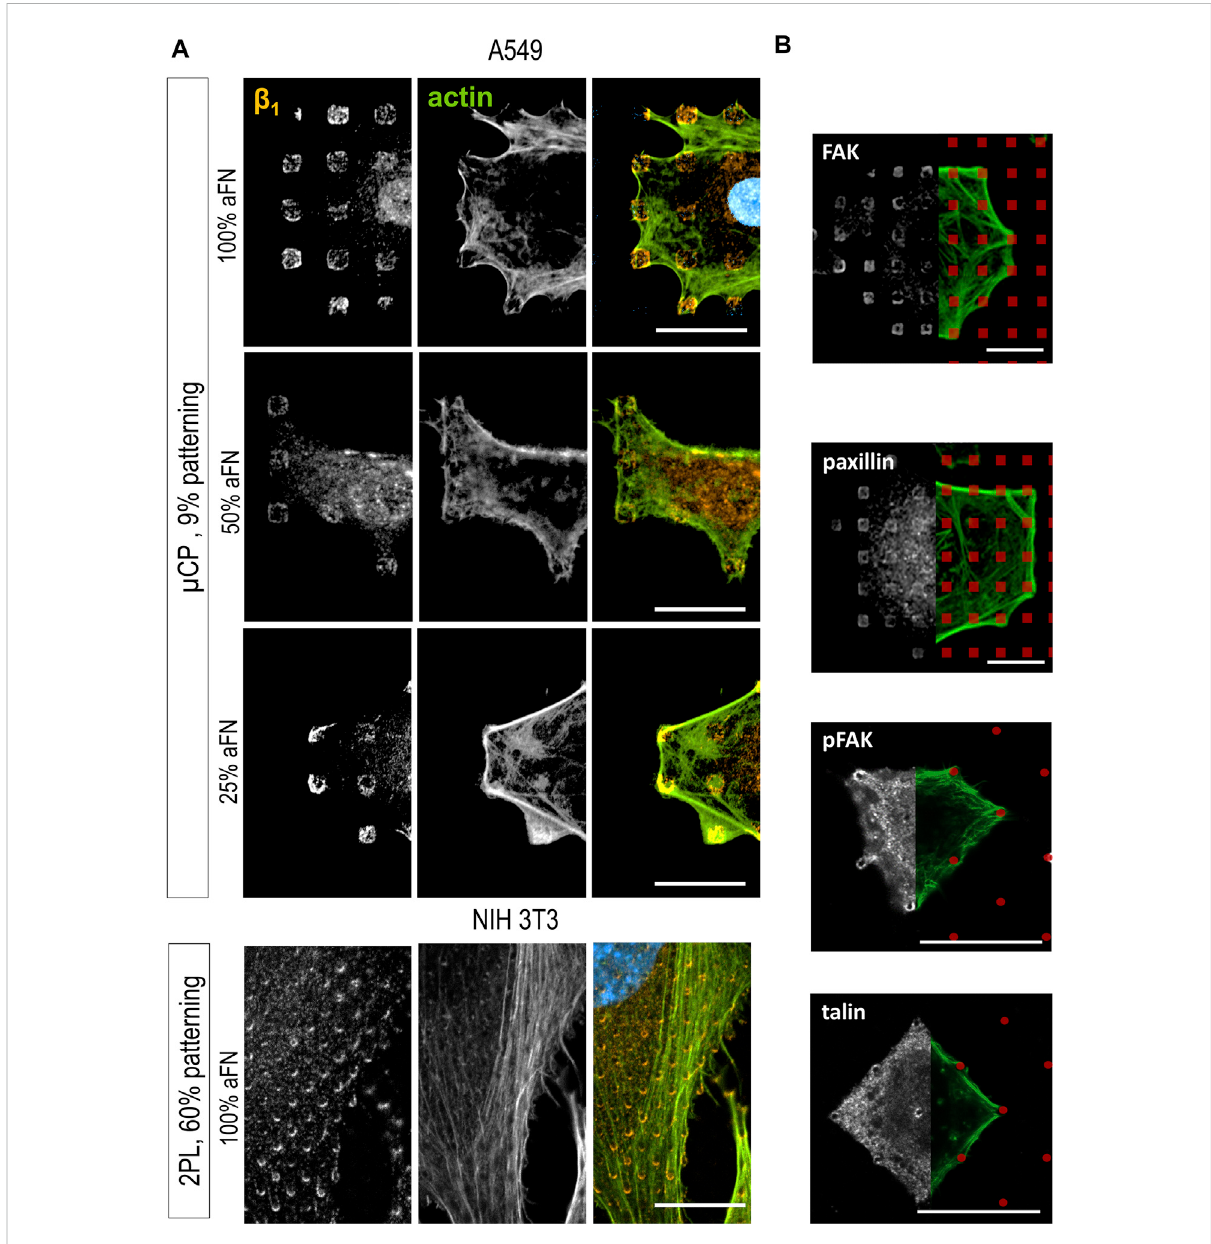
FIGURE 3 Cell spreading is β 1-mediated. (A) β 1 integrin is detected centrally and peripherally on patterns, independently on aFN dilution, fabrication system and cell line. (B) Other proteins involved on FAs are detected only peripherally (FAK, paxillin, pFAK), or centrally and peripherally (talin). FN- coated patterns are red-coloured for eye guidance. Scalebar 20